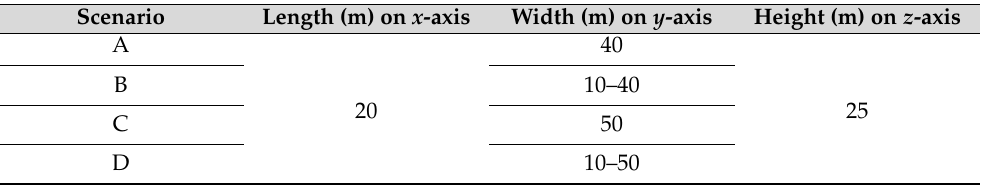
Table 4. Input parameters considered for the optimisation problem Source: